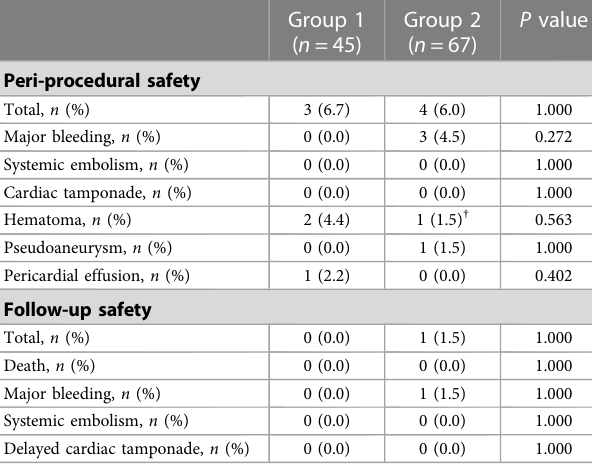
TABLE 4 Peri-procedural and follow-up safety.